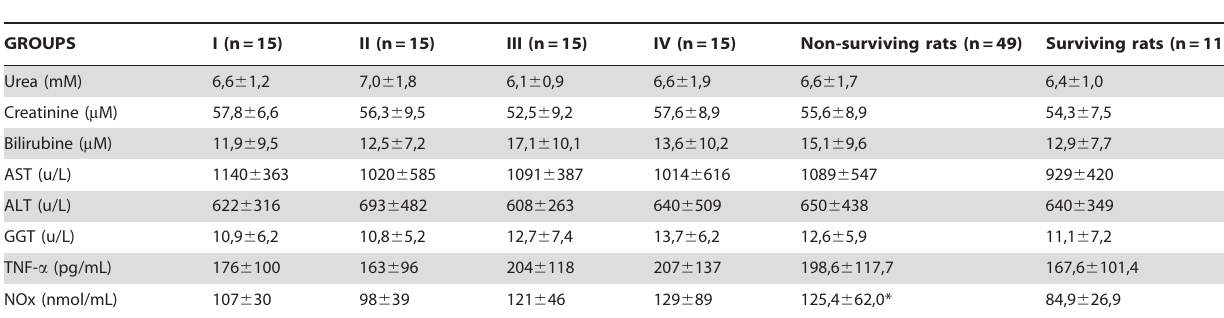
Table 1. Basal analytical parameters of the groups of cirrhotic rats with induced bacterial peritonitis.